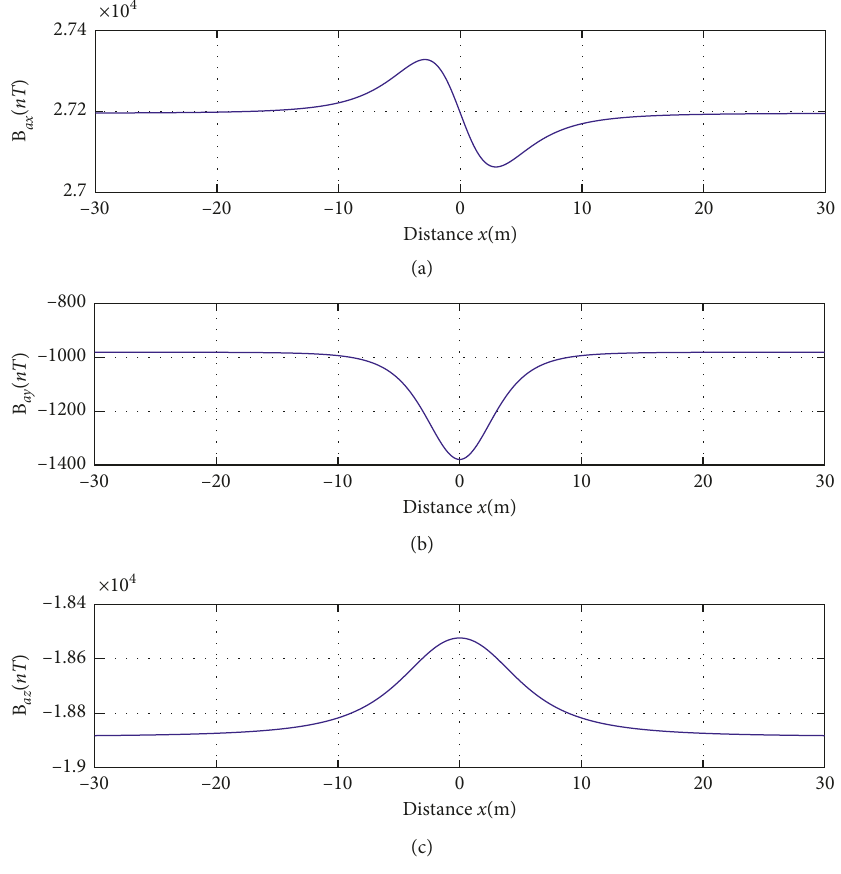
Figure 6: (a) B , (b) B , and (c) B present in vehicular magnetic anomalous fields in x, y , and z directions. ax ay az